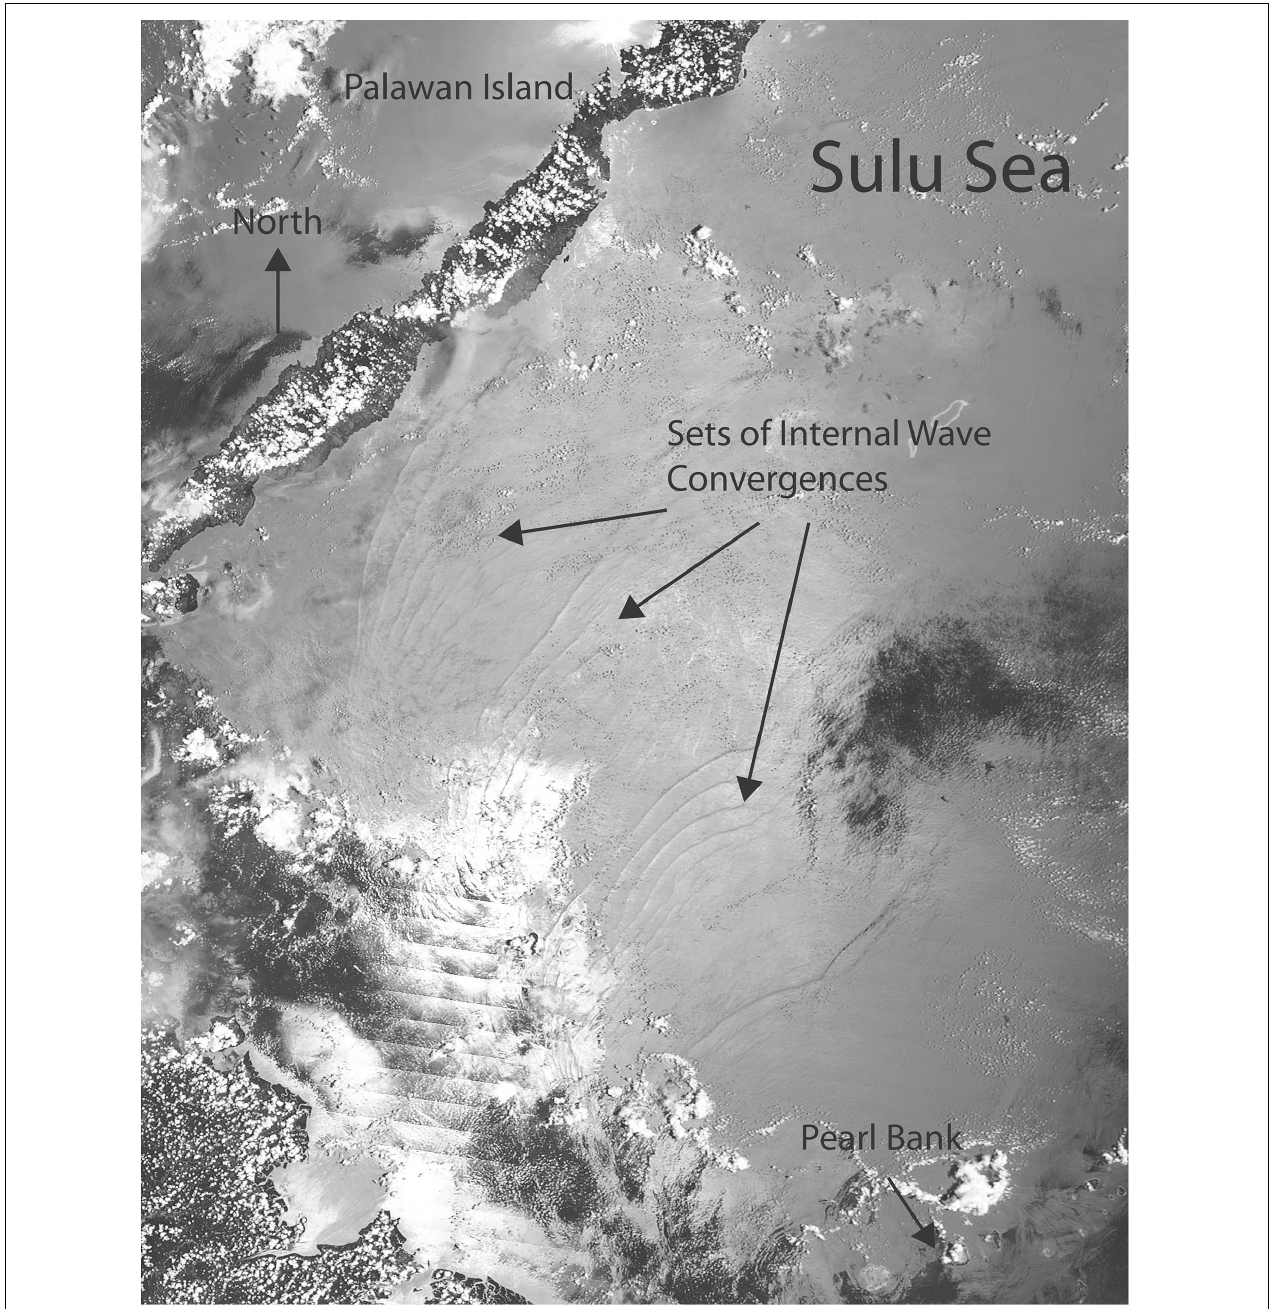
FIGURE 1 | Satellite image of internal wave convergences in the Sulu Sea. The sets of internal waves were formed by the interaction of tidal currents with the Pearl Bank and adjacent reefs (5.85 N, 119.85 E). From this point of origin the waves propagate across the Sulu Sea (about 450 km) and, ultimately, run ashore on Palawan Island. Each set of waves was formed during a tidal change, hence, the set of waves closest to Palawan Island had been propagating across the Sulu Sea for about 2 days. Image is from the Internal Wave Atlas (http://internalwaveatlas.com/Atlas2_PDF/IWAtlas2_Pg393_SuluSea2.pdf) and is a compilation of MODIS Bands 1, 3, and 4. The vertical axis of the image is approximately 500